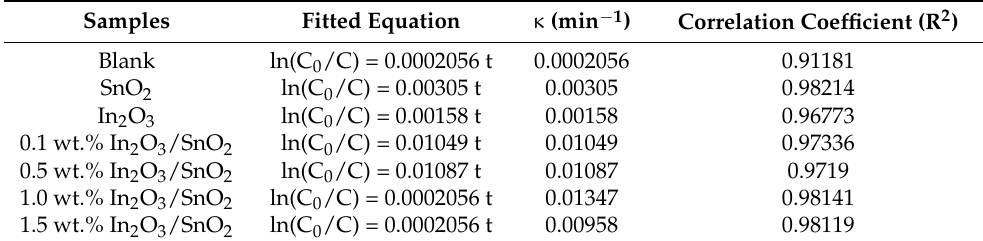
Table 1. The fitted equation, the rate constant κ and correlation coefficient (R 2 ) of as-prepared samples. Samples Fitted Equation κ (min − 1 ) Correlation Coefficient (R 2